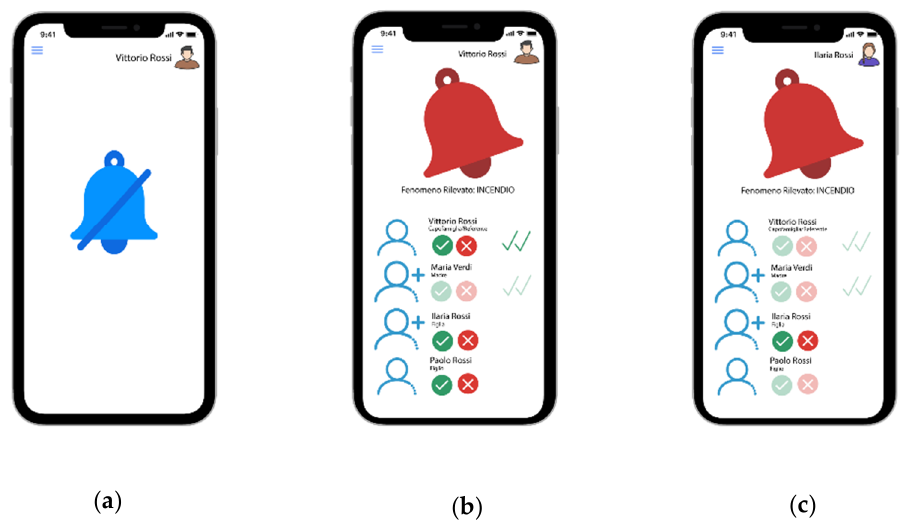
Figure 19. ( a ) No alert is set; ( b ) the feedback process; ( c ) the family state communication.